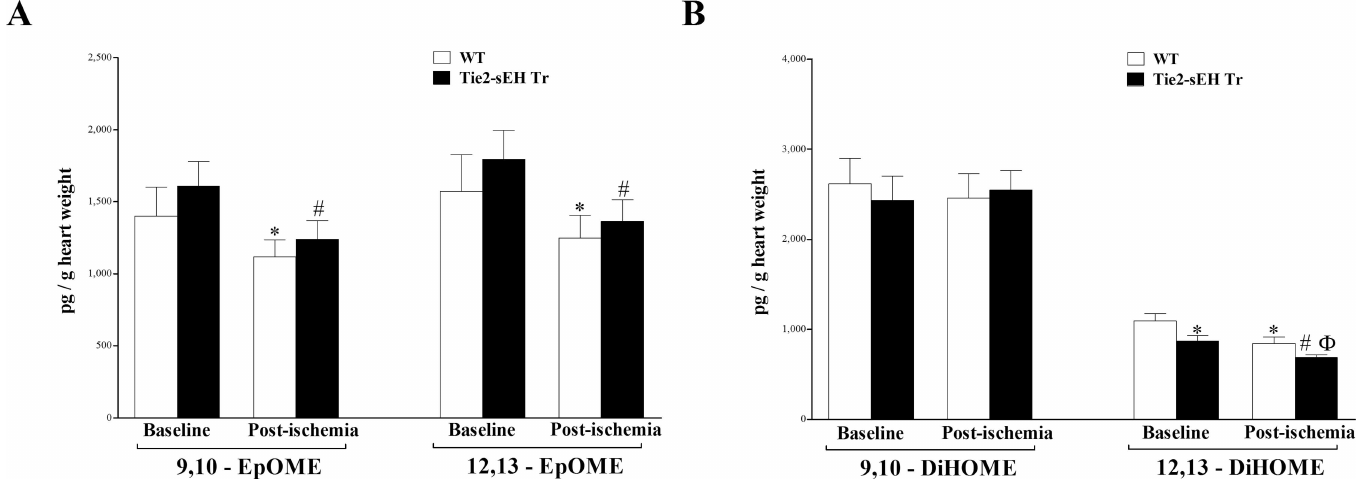
Fig 4. LC–MS/MS analysis of EpOME and DiHOME levels in WT and Tie2-sEH Tr mouse heart perfusates at baseline and post-ischemia. 9,10- and 12,13-EpOMEs (A) were decreasedin responseto ischemia in both WT and Tie2-sEH Tr mice ( P < 0.05), but were not different betweenthe two groups ( P > 0.05). 12, 13-DiHOME(B) level was decreasedin Tie2-sEH Tr comparedto WT mice ( P < 0.05), and was decreased in responseto ischemiain both mouse groups ( P < 0.05). 9,10-DiHOME level (B) did not changedue to ischemiaor to sEH endothelialexpression( P > 0.05). * P < 0.05 versus baselineWT. # P < 0.05 versus WT post-ischemia. n = 12 WT and 14 Tie2-sEH